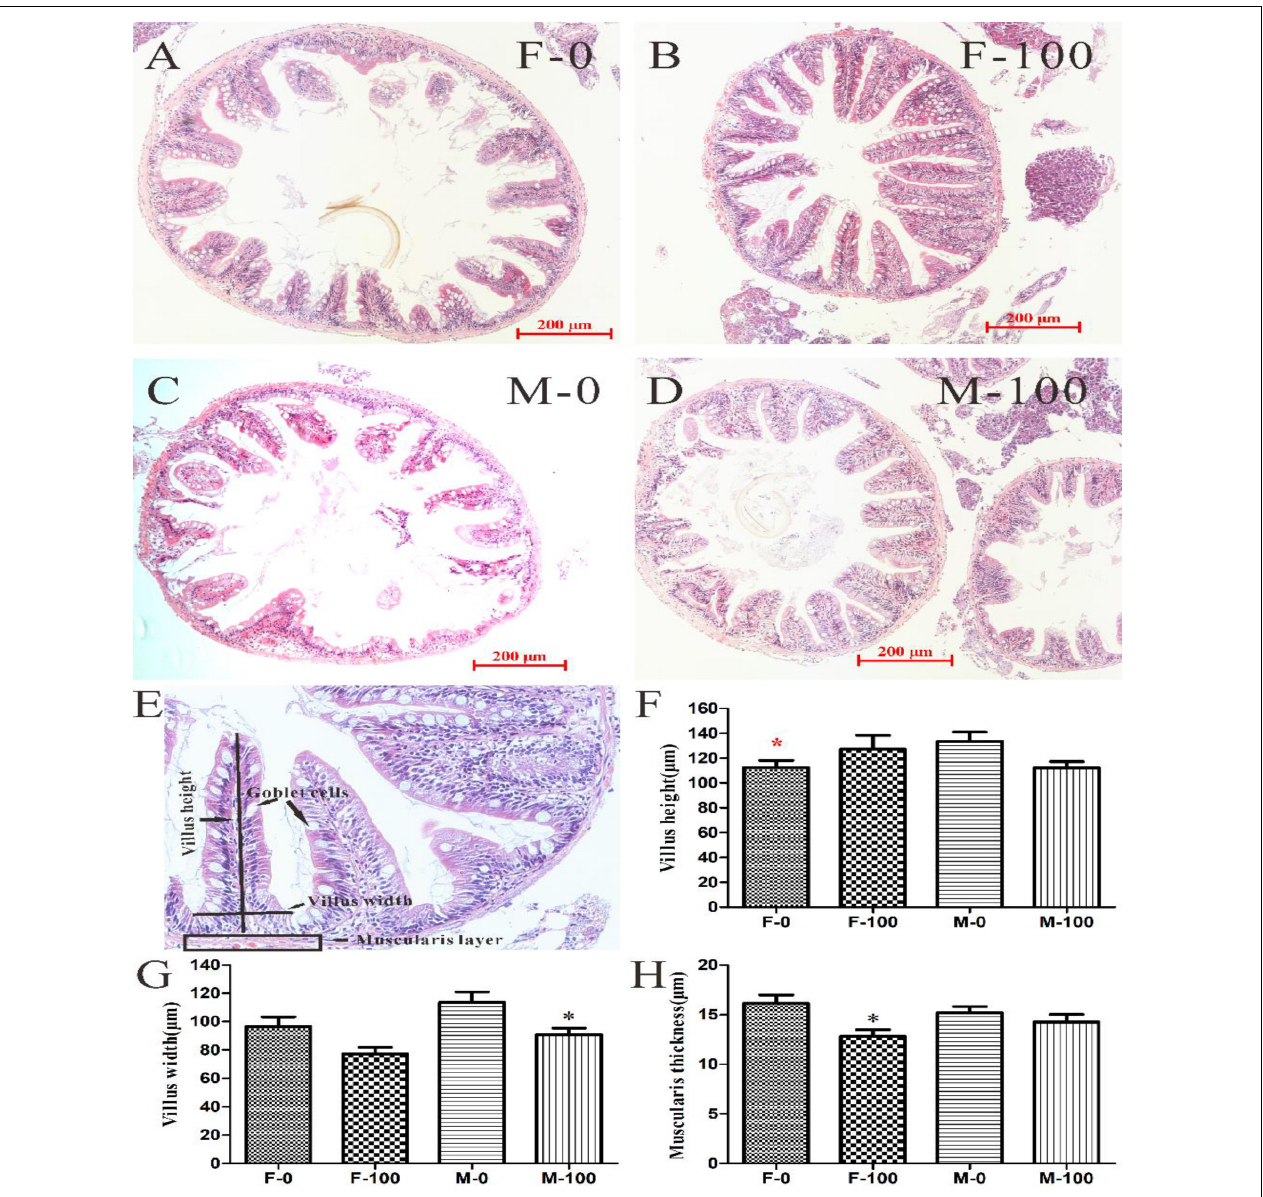
FIGURE 4 | The histomorphological analysis of zebrafish intestine tissues with H&E stain. The histological analysis of gut tissue in female (A) and male (C) zebrafish in the control group, female (B) and male (D) zebrafish in 100 µ g/L DEHP treatment group. According to the gut tissue indexes (E) , the height (F) and width (G) of villi, and muscular thickness (H) were measured from sections with 200 µ m scale bar and 200 × images. And the symbol black * indicated p < 0.05 as the significant changes compared to control, the red * stands for the p < 0.05 as the significant changes of F-0 vs M-0.